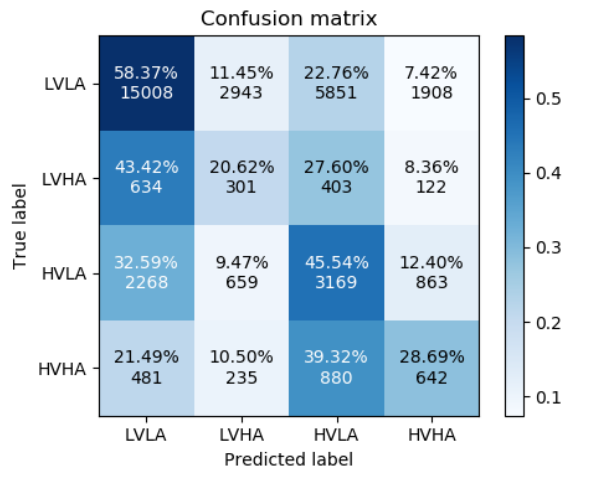
Figure 5. Confusion Matrix for Experiment 1.